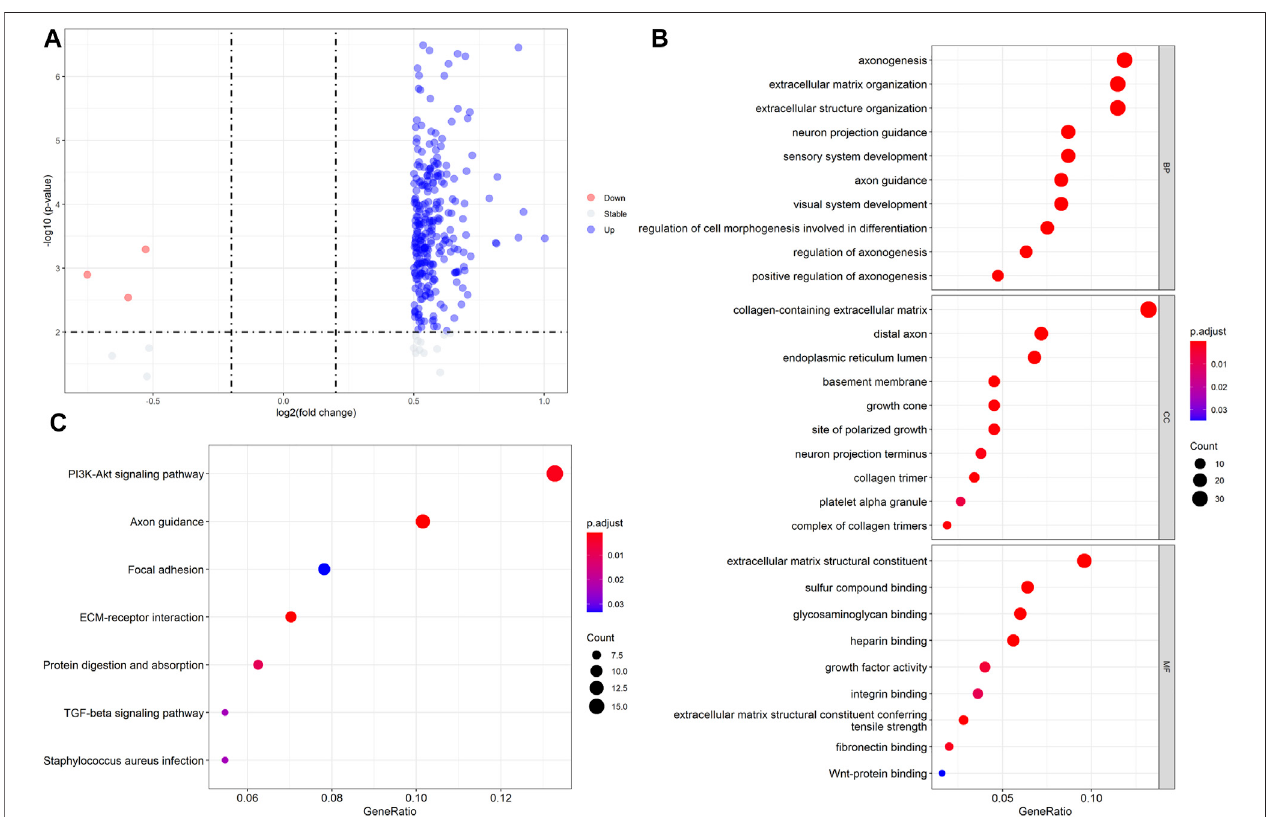
FIGURE 2 | Identifying differentially expressed genes (DEGs) related to mRNAsi scores and the functional analysis. (A) Volcano plot of DEGs between high and mRNAsi scores; (B) GO functional enrichment analysis for the DEGs; (C) KEGG analysis for the DEGs.